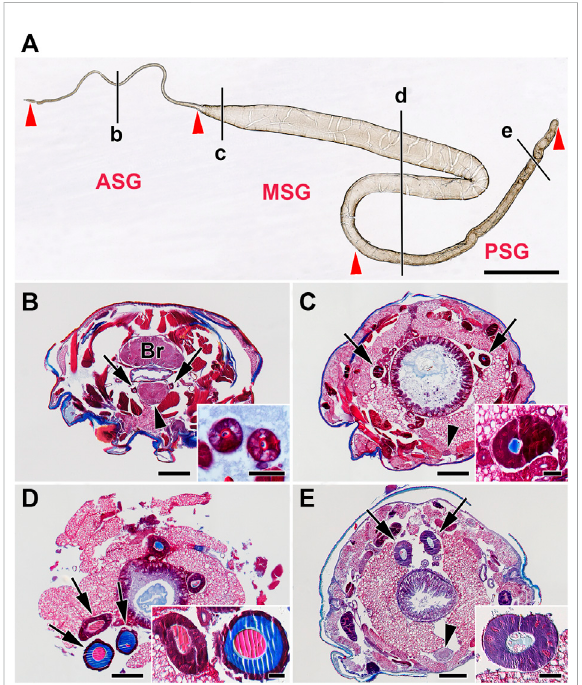
FIGURE 1 Morphologyofthesilkgland(SG)from E.kuehniella lastinstar larvae. (A) WholemountpreparationofoneSGillustratesitsoverall morphology. Red arrowheads depict the boundaries of the SG compartments, where ASG = anterior SG, MSG = middle SG, and PSG = posterior SG. Black lines marked by the lowercase letters b – e refer to the whole-body sections B – E and show the approximate positions where the glands were cut in transverse Paraplast sections. (B – E) Transverse Paraplast sections through the body of the last larval instar stained with Masson trichrome stain (Sigma). The inset images show higher magni fi cation of the SG sections marked by arrows. (B) ASG; brain (Br); the arrowhead depicts the suboesophageal ganglion (SOG). (C) Anterior portion of the MSG; arrowhead shows ventral nerve cord. (D) MSG in the region of the sigmoidal loop. (E) PSG; the arrowhead marks the ventral nerve cord ganglion. Red areas are acidic; blue areas are alkaline. Scale-bars: (A) , 1,000 μ m; (B – E) , 200 μ m; inset images, 50 μ m.